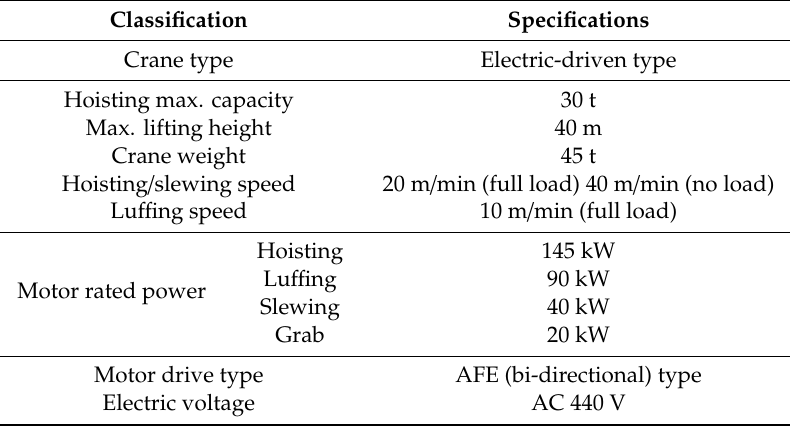
Table 7. Specifications of the selected deck